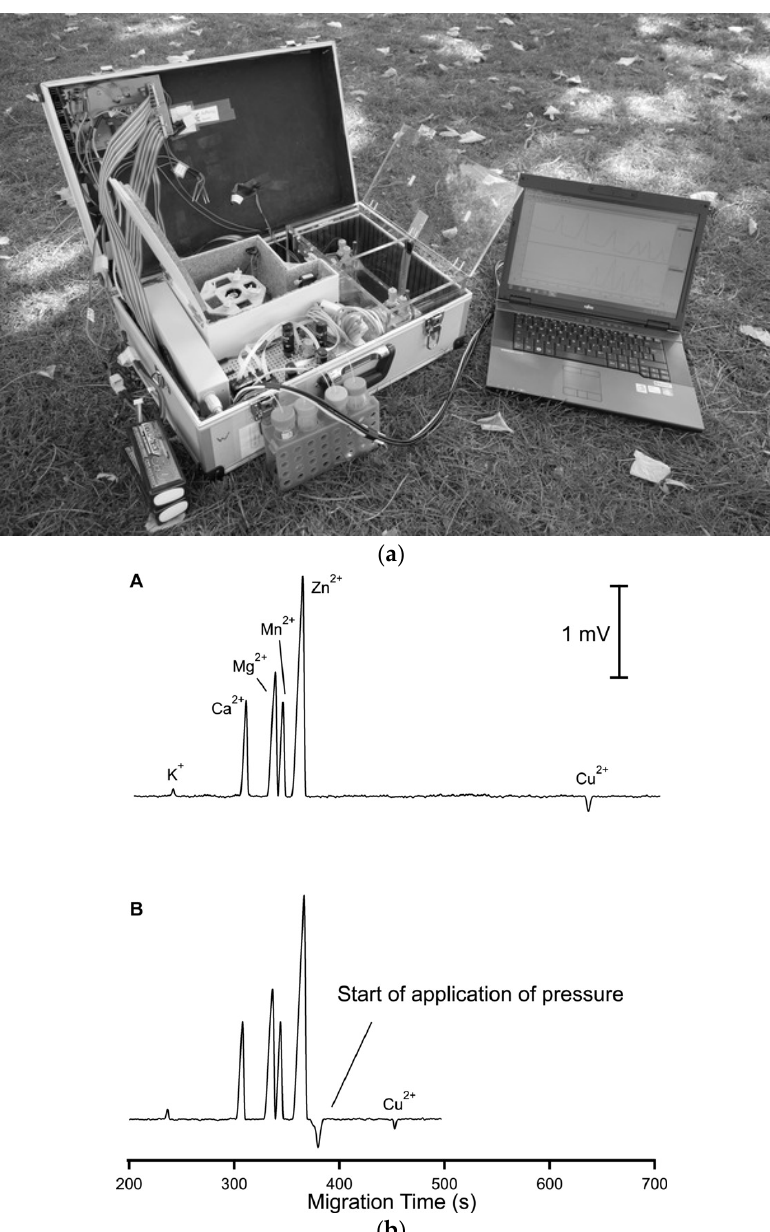
optimization of separation conditions. The system is controlled by a computer and works automatically. The electropherograms of a sample of mining pond water are shown in Figure 9. Because the migration time for the copper ion was relatively long compared to the other analytes, pressure assistance was applied to shorten the analysis time.